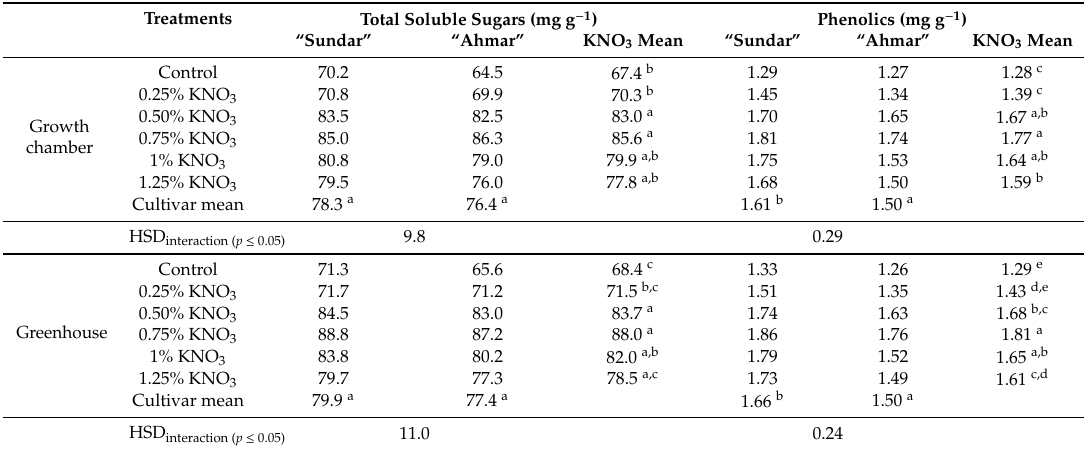
Values sharing the same letters are non-significantly di ff erent ( p ≤ 0.05). Table 4. Variations in biochemical attributes of two tomato cultivars under the influence of seed priming with KNO 3 in two di ff erent growth